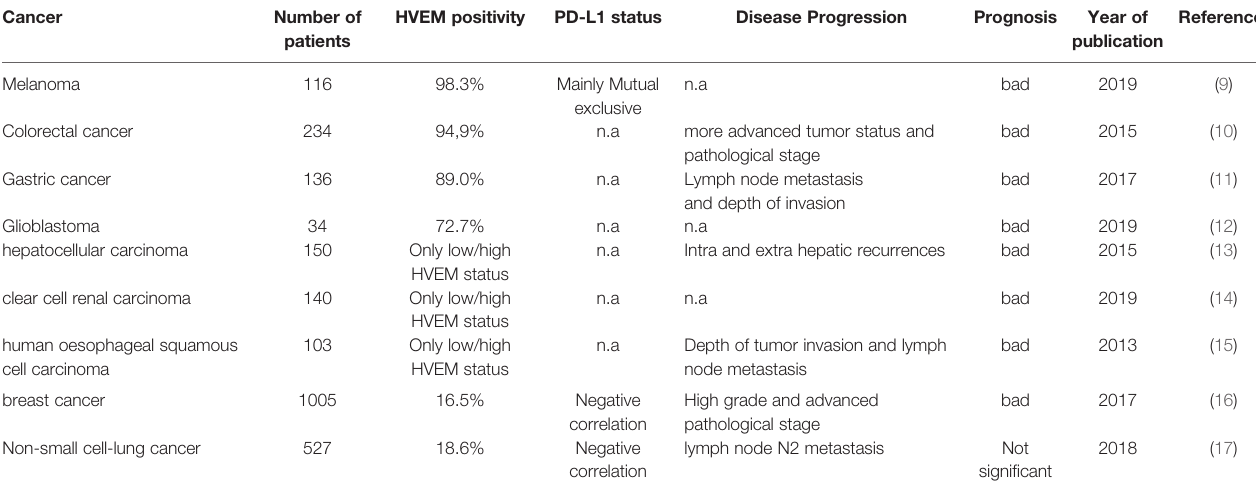
This table reviews the published studies on HVEM expression and correlation with disease progression and prognosis. (n.a, not assessed).